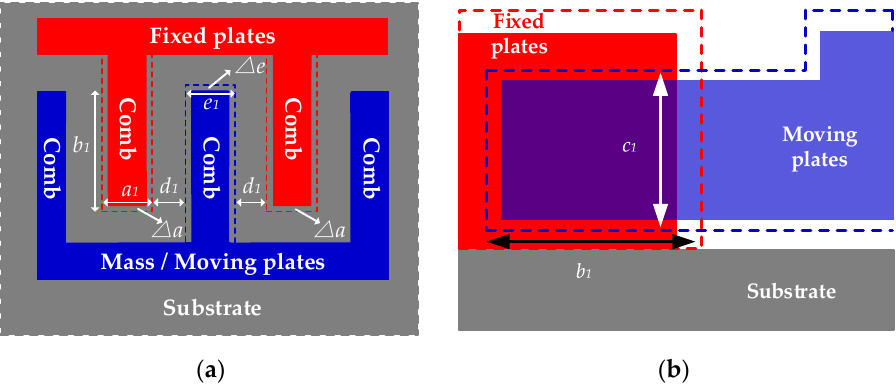
Figure 5. Deformation of the combs when